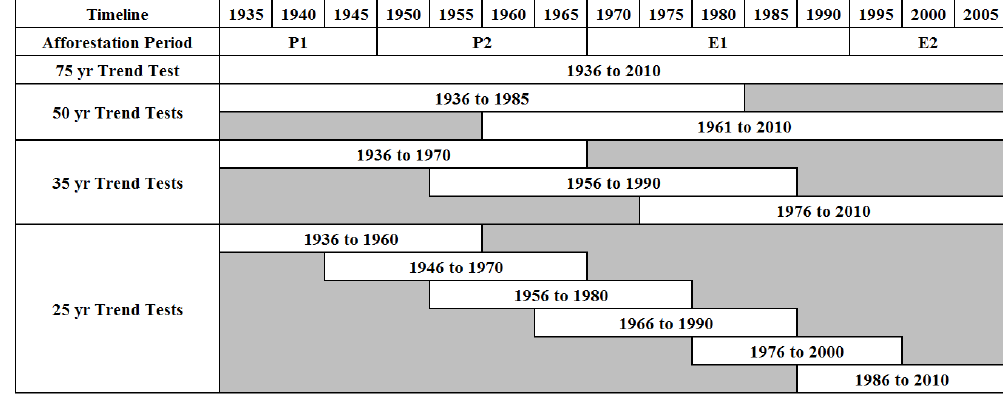
Figure 4. Timeline of the trend-testing periods and their correspondence with the different afforestation